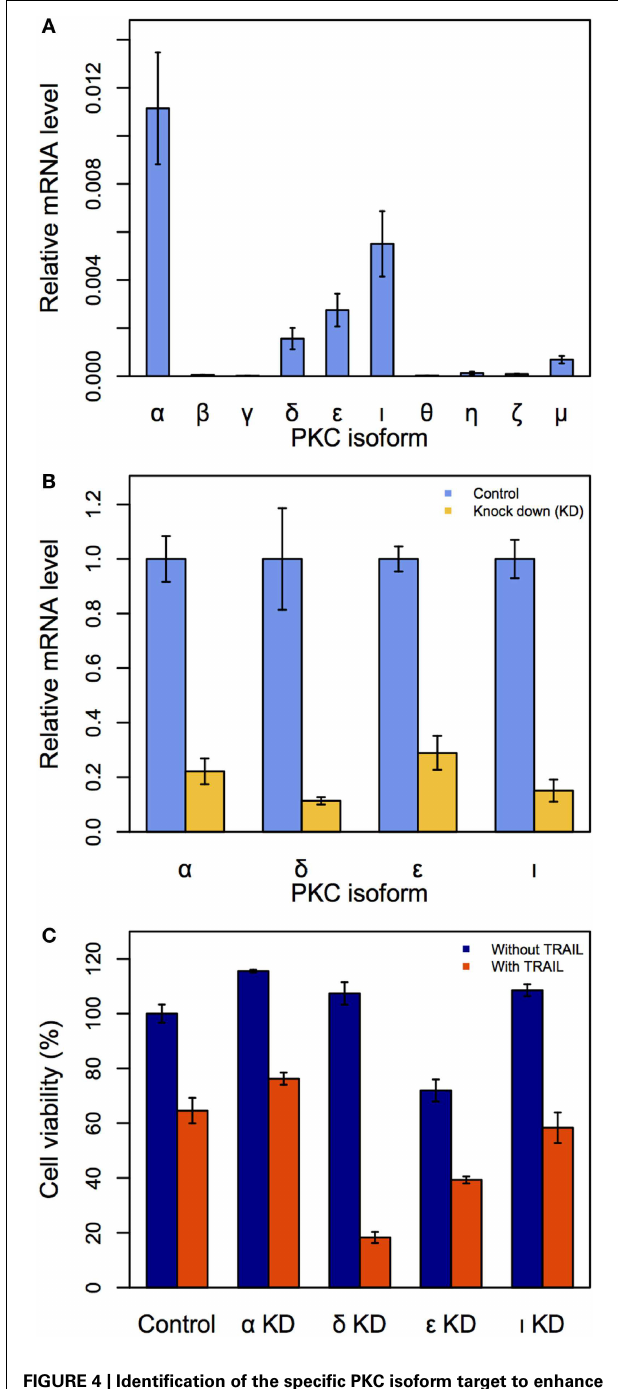
FIGURE 4 | Identification of the specific PKC isoform target to enhance apoptosis in HT1080 cells . (A) Relative mRNA expressions of 10 PKC isoforms in HT1080 unstimulated cells. (B) Effect of siRNA knock-down (KD) for PKC α , PKC ι , PKC ε , and PKC δ . HT1080 cells were incubated in the presence of each PKC isoform siRNA (50 µ M) for 24h. Relative mRNA expressions of four PKC isoforms are measured by qRT-PCR. (C) Cell viability assay (trypan blue) of HT1080 cells incubated in the presence of PKC isoforms siRNA (50 µ M) for 3h. Error bars indicate mean values ± SD. for n = 3 independent